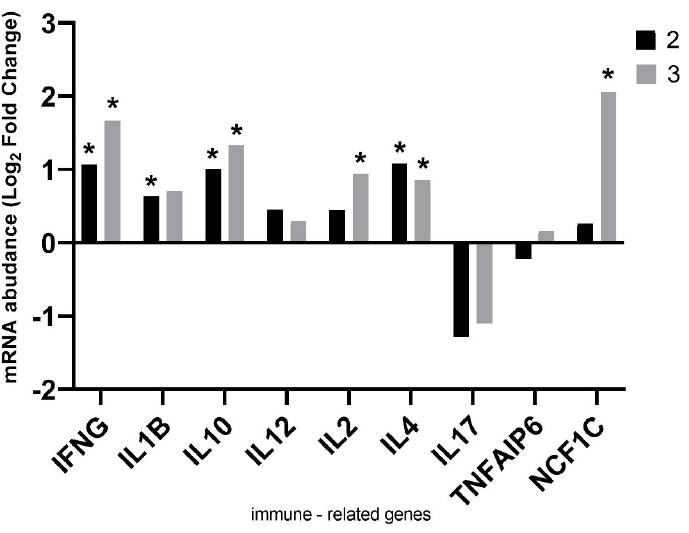
Figure 3. Relative gene expression of immune-related genes in cecal mucosa in chickens fed with the addition of halloysite and zeolite, as well as the addition of pulverized halloysite (group 2) and zeolite (group 3) to the litter. Statistical analysis consisted of comparing the experimental groups with the control group using Student’s t -test (* for p- value < 0.05).